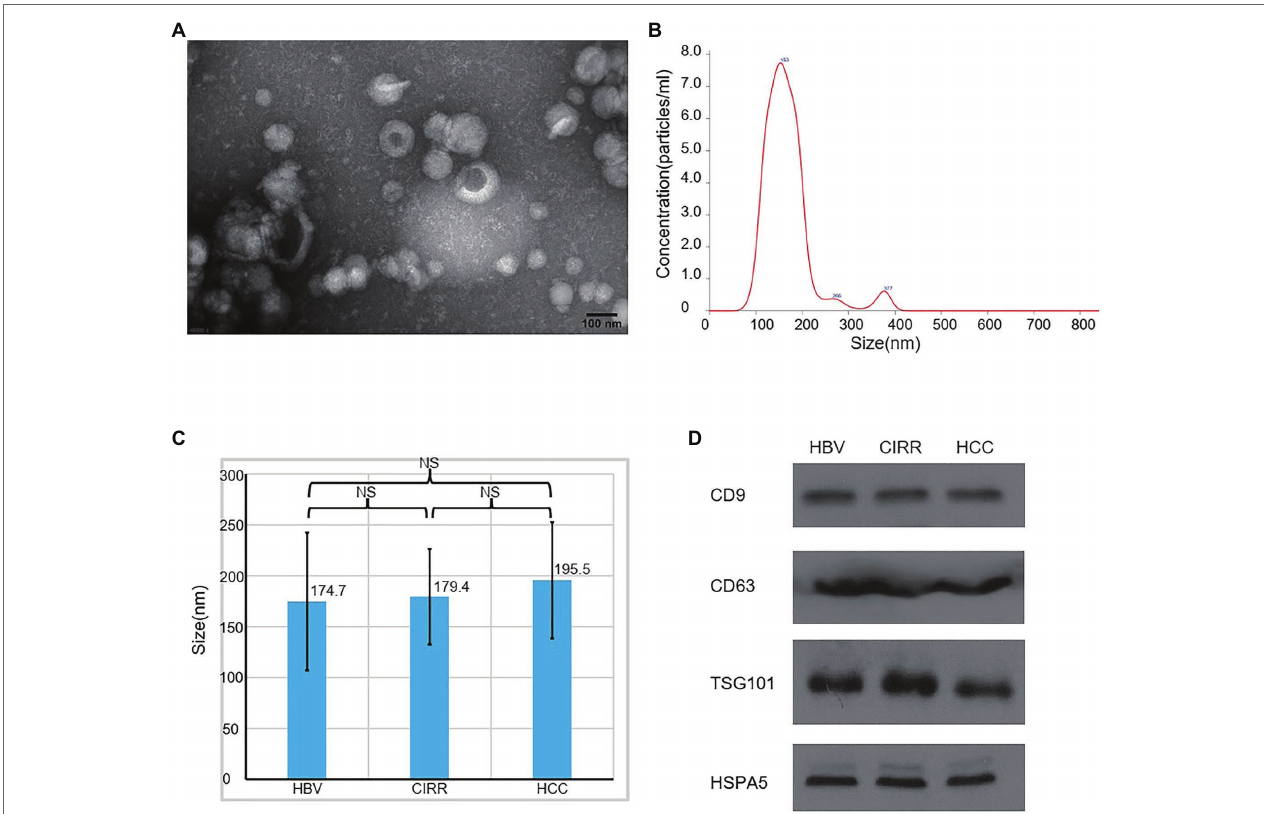
FIGURE 1 | Characterization of serum exosomes of chronic HBV, cirrhosis, and HCC individuals. (A) A representative TEM image of exosomes; (B) the size range of the exosomes revealed by NAT analysis; (C) the histogram showing the difference of the size range between groups. (D) WB analysis of exosomal markers including CD9, CD63, TSG101, and HSPA5. HBV, hepatitis B virus; CIRR, cirrhosis; HCC, hepatocellular cancer; and NS, not